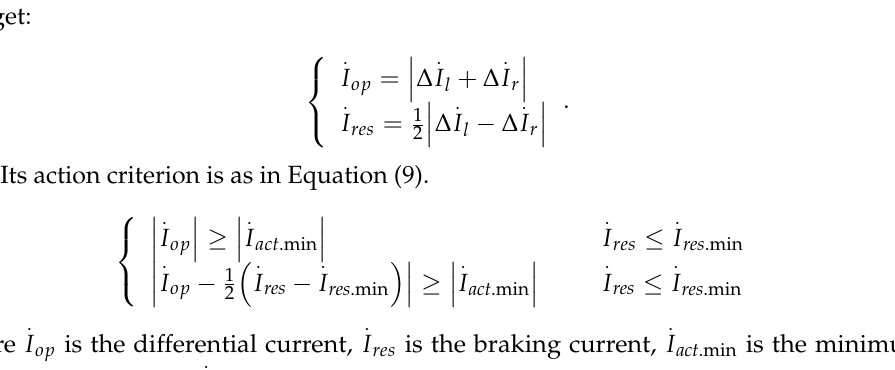
Z and are the ls Z is the excitation imped- m